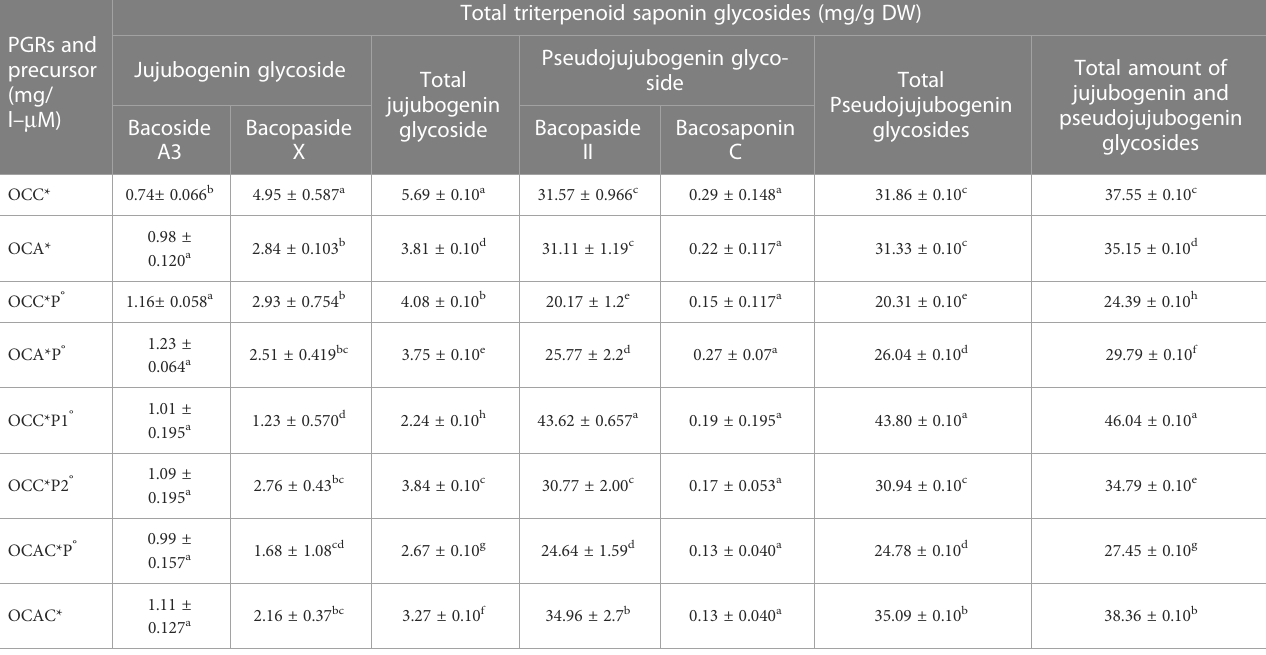
TABLE 7 Effects of optimal concentrations of PGRs and precursor combinations on total triterpenoid saponin glycosides (jujubogenin glycoside and pseudojujubogenin glycoside) from in vitro grown biomass of Bacopa fl oribunda